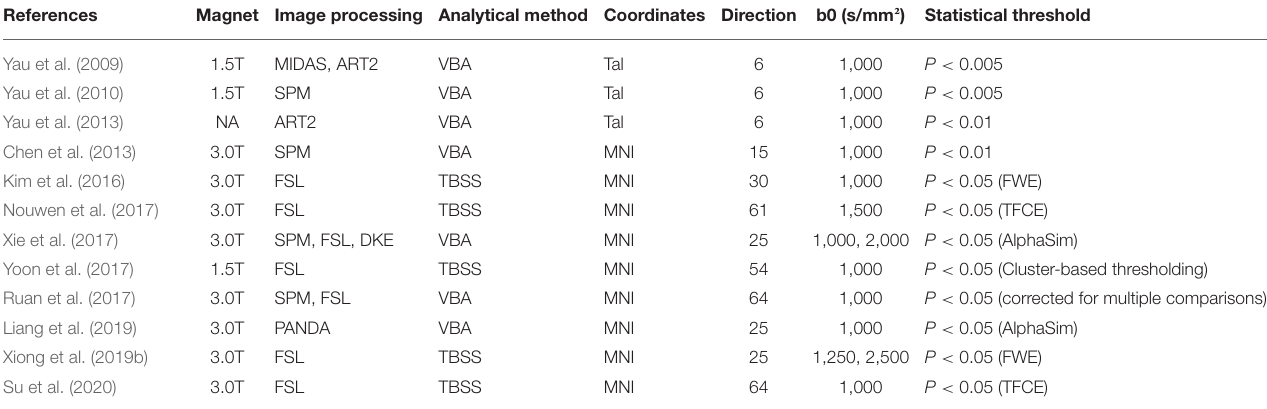
TABLE 2 | Diffusion tensor imaging (DTI) parameters and analysis methods in the studies of the meta-analysis.